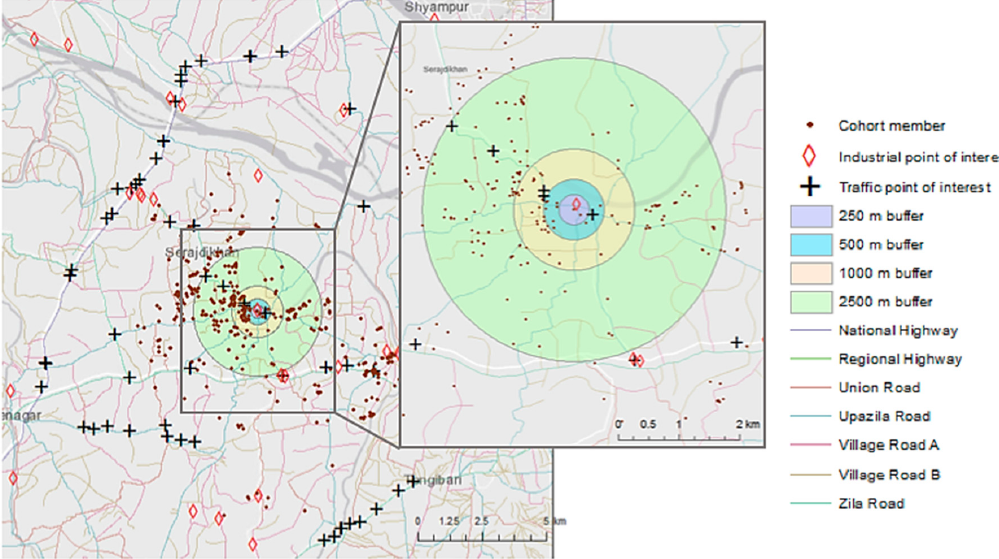
Figure 2. Geographical distribution of identified industries, traffic point and line sources, and a visualization of the 250 m, 500 m, 1000 m, and 2500 m buffers surrounding each cohort member in which sources were indexed. Table 4. Multivariate regression results for (A) the model evaluating the relationship between blood lead levels (BLLs) and air lead concentrations, interpolated by inverse squared distance weighting and adjusted for age, sex, and maternal education; and (B) the model evaluating the relationship between BLLs and number of industrial points of interest and length of major roadways within 250 m, 500 m, 1000 m, and 2500 m buffers of the residences.